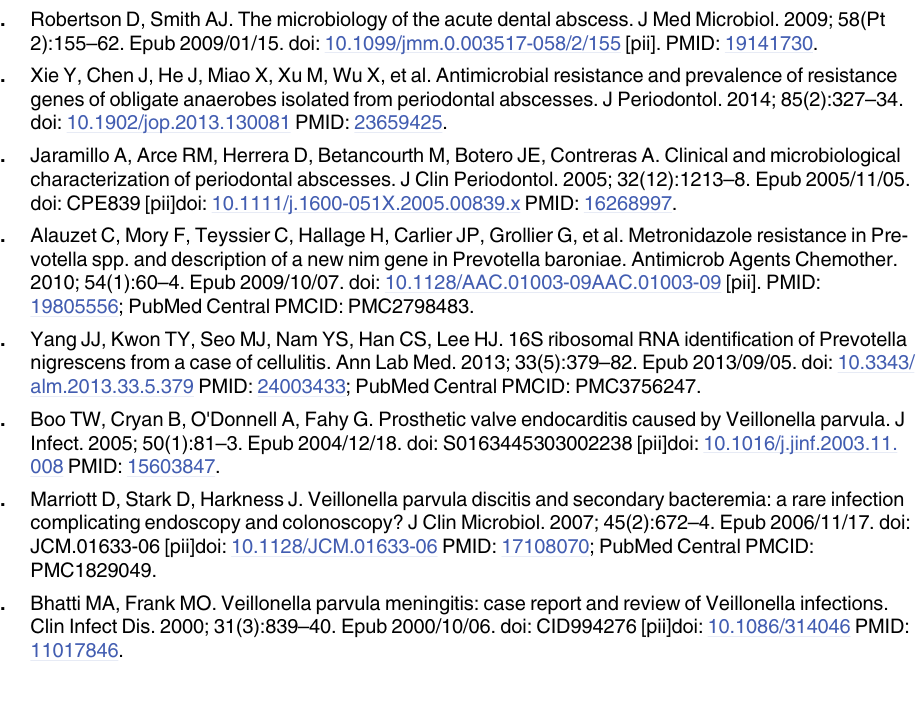
S3 Fig. Phylogenetic trees based on the concatenated sequences of the recA gene. The trees were constructed by the neighbour-joining (NJ) method. The numbers at nodes indicate the percentage bootstrap values of 1000 replicates ( > 70%). Bars indicate the expected nucleotide substitutions per site. (cid:1) represents reference strains. S1 Table. Primers and PCR conditions used in the study. (DOCX) S2 Table. Bacterial strains used in this study and their accession numbers in the databases. (DOCX) S3 Table. Sequence similarity based on pairwise comparisons of the 16S rRNA, gyrB1, hsp60, rpoB, recA and dnaJ sequences of Prevotella species. Green, pink, blue, yellow and open-shaded rectangles indicate > 50%, > 60%, > 70%, > 80% and > 90% sequence similar- ity, respectively. (cid:1)(cid:1)(cid:1) indicates that data are not available because there is only one strain in the genus.